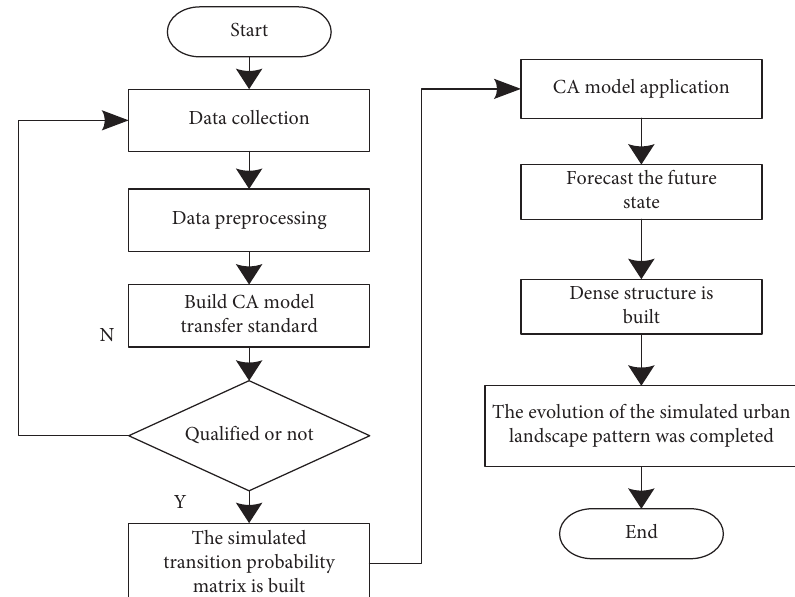
Figure 2: Flowchart of the evolution of the simulated urban landscape